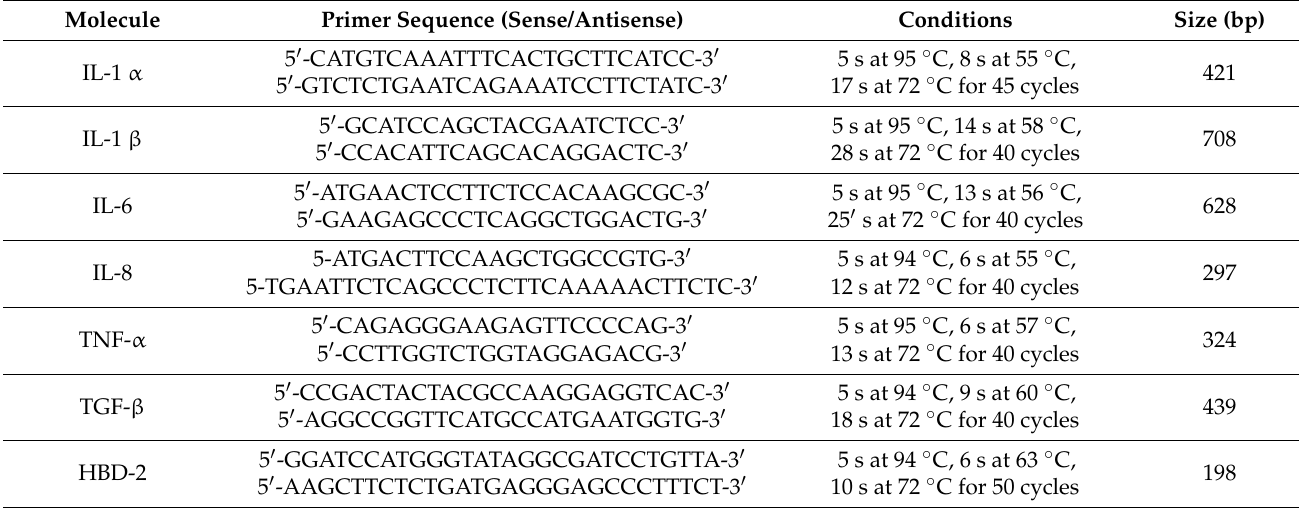
Table 1. The details of the quantitative reverse transcriptase polymer chain reaction (qRT-PCR). This includes operational conditions, gene, primer sequences, and product